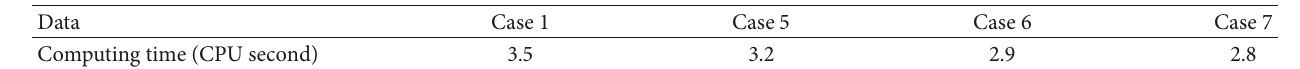
Table 11: Computing time of CMA-ES.